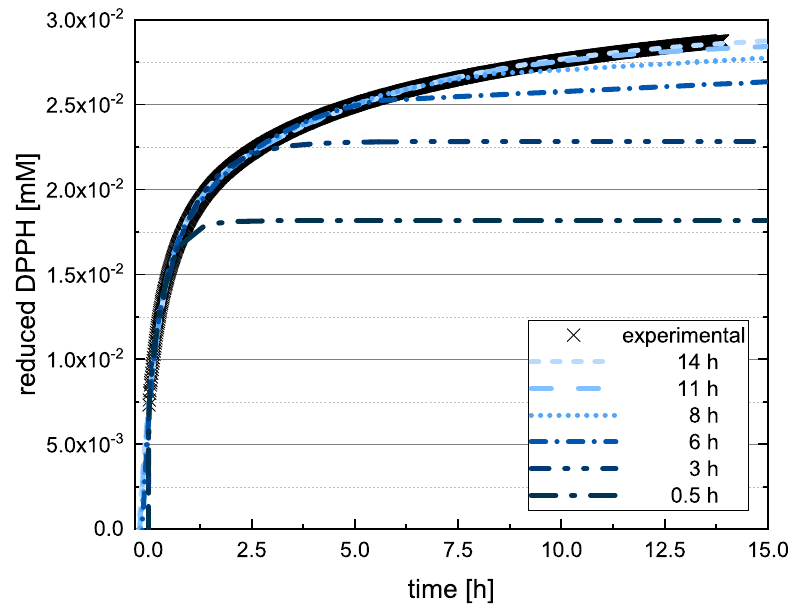
Figure 4. Representative measurement curve of the quantity of reduced DPPH radical in reactions with EPC as a function of time. Equation (12) is adapted for different time